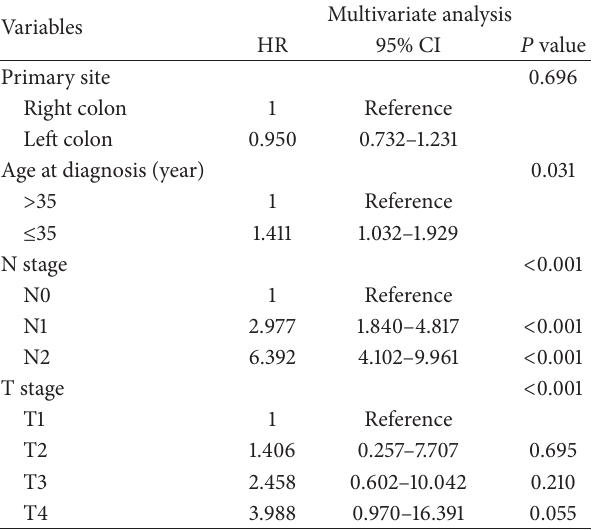
Table 3: Multivariate analyses of determinants of cancer-specific survival (CSS) of patients with nonmetastatic signet-ring cell car- cinoma of the colon.